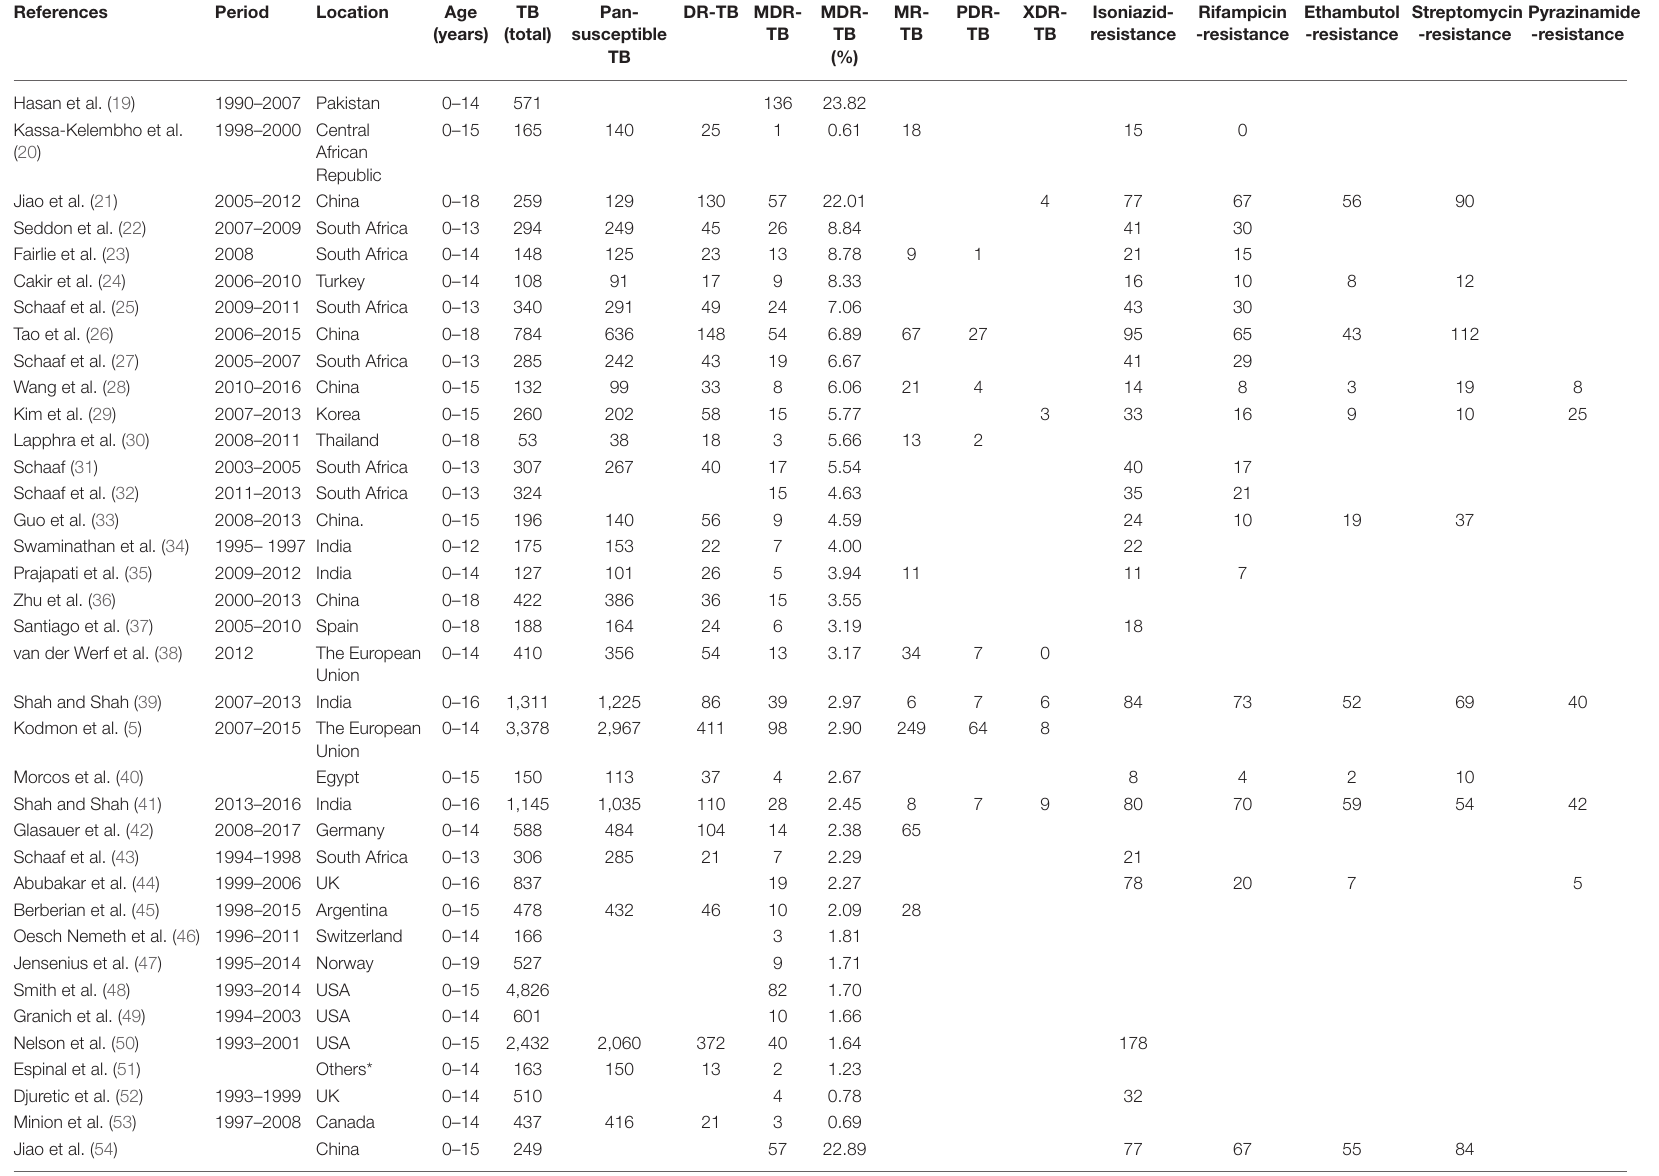
TABLE 1 | Overview of 37 studies and 23,652 children tuberculosis cases with drug susceptibility